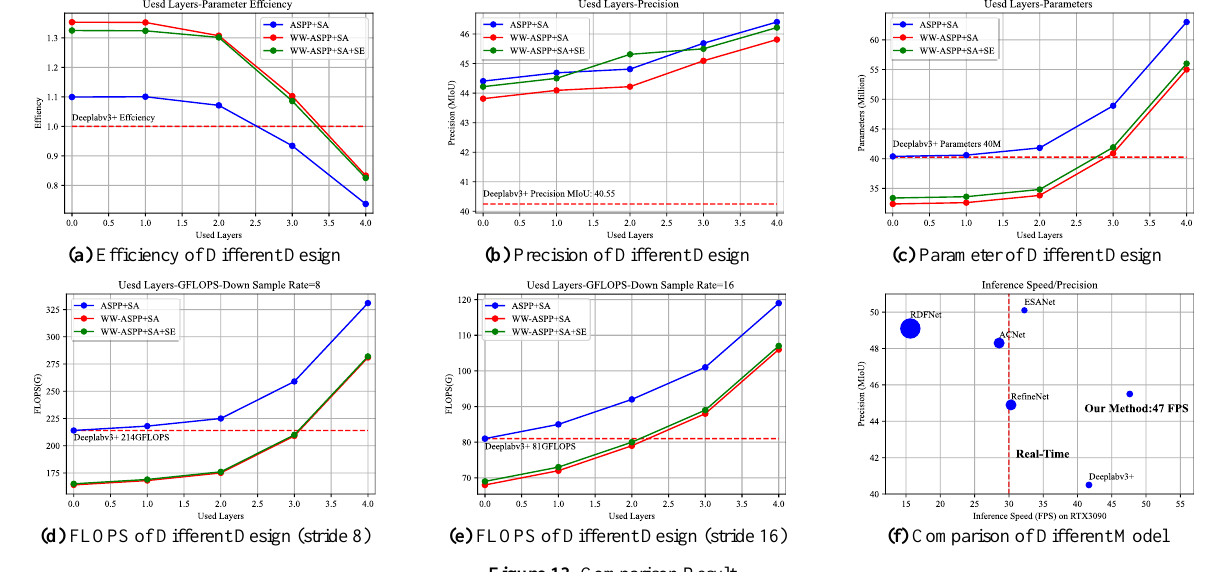
Figure 13. Comparison Result. The subplot (a)-(e) shows comparison result of different module and layer of backbone used in PSCNet. Subplot (f) shows comparison result of different Model.